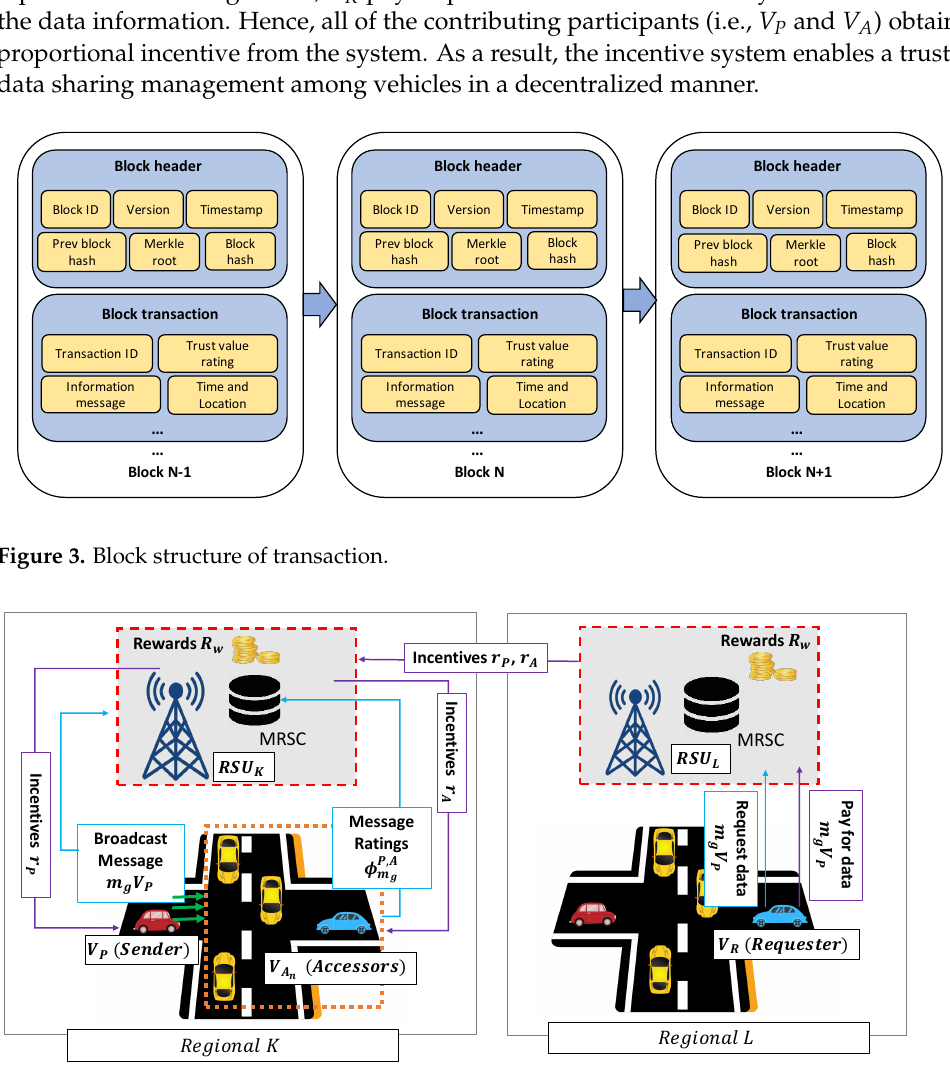
Figure 4. Illustration of incentive